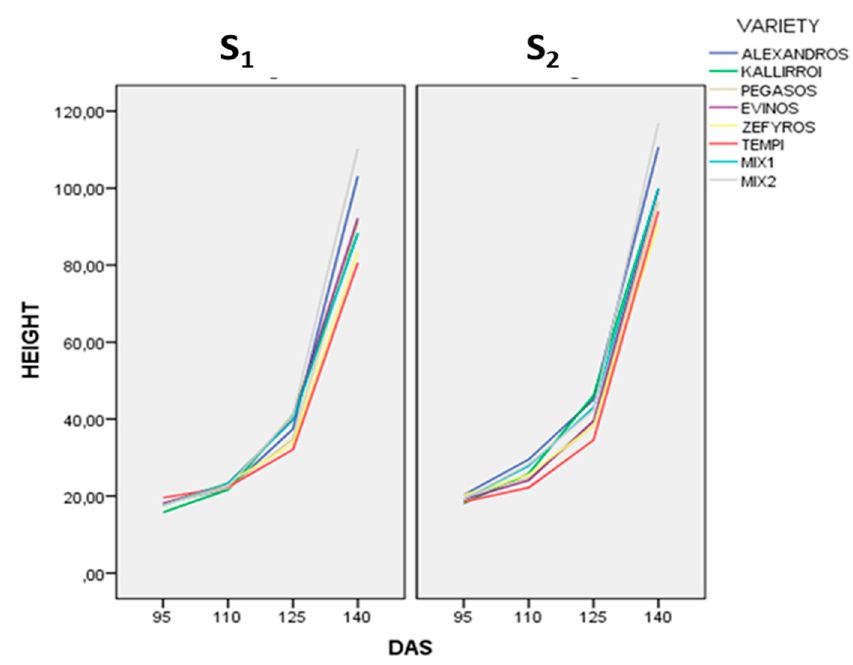
Figure 2. Variation rate of plant height (cm) of six cultivars and two mixture cultivars of common vetch in two seed rates (S 1 :100 kg ha − 1 ; S 2 :180 kg ha − 1 , as a two-year average. DAS indicate days after sowing.